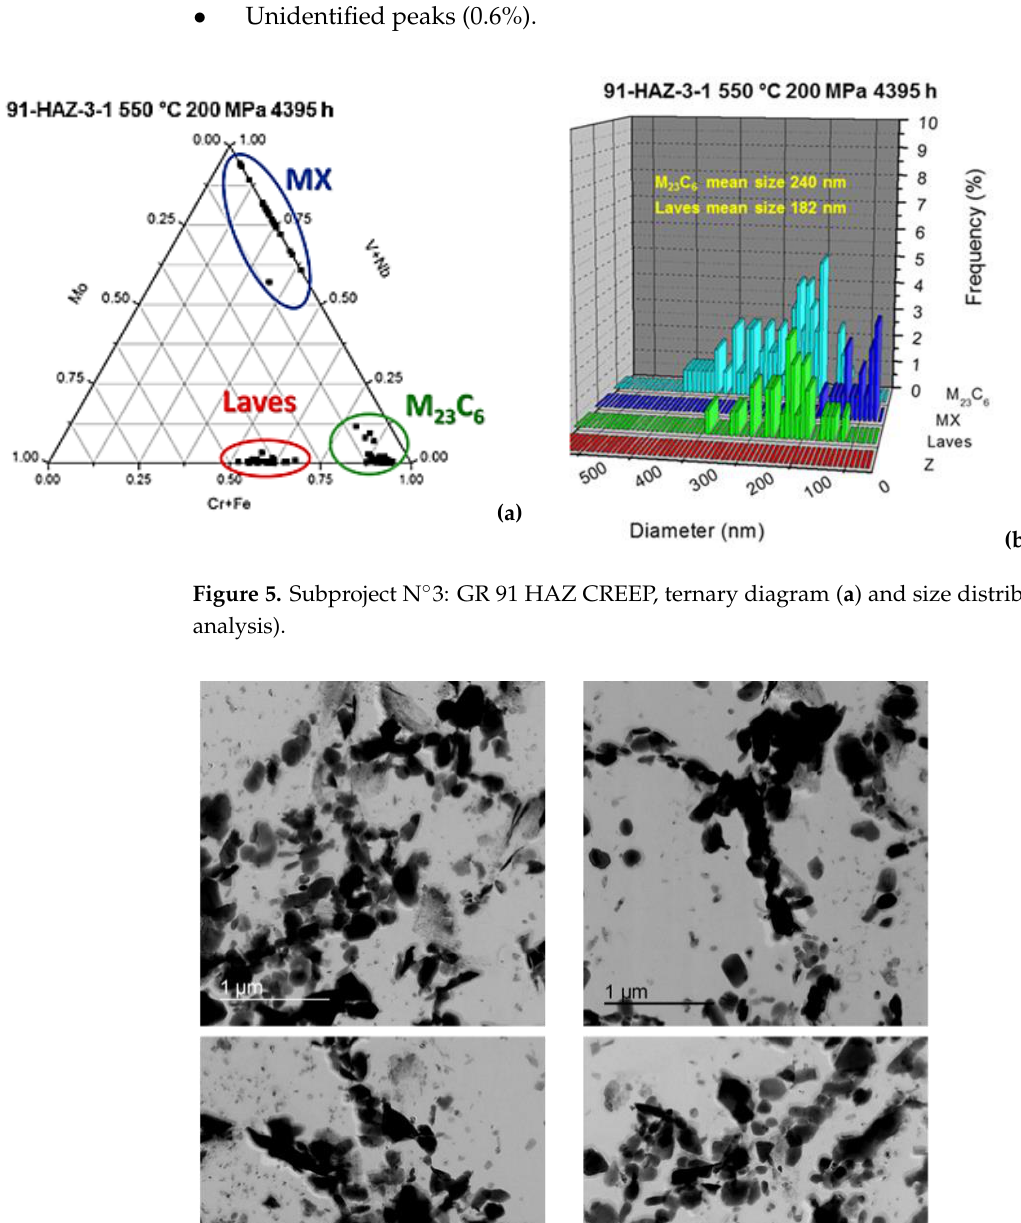
Figure 6. Failed crept cross-weld specimen 91-HAZ-3-1 550 °C 200 MPa 4395 h. TEM images on a carbon extraction replica at 50,000 X; MX (clear points), M 23 C 6 (black and generally elongated areas), and few Laves phases (black rounded areas) are present.